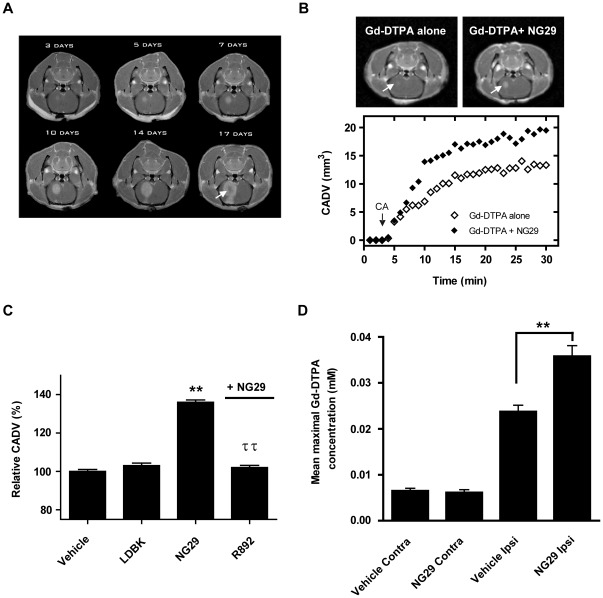
NG29 enhances transvascular delivery, distribution and accumulation of Magnevist within brain tumor tissues of F98-bearing rats.(A) MRI contrast-enhanced detection of glial brain tumors in rats at day 3, 5, 7, 10 14 and 17 post-inoculation. Note the rapidly growing tumor over a 2-week time and the appearance of a necrotic center on the 17 day-image (white arrow) outgrowing its blood supply. Assessment of BTB disruption by MRI monitoring was conducted on the same animal on day 10 post-inoculation, corresponding to mid stage development of the tumor. (B) Representative axial Magnevist-enhanced T
1-weighted MR images depicting the brain of an F98-implanted rat before and after NG29 treatment (10 nmol/kg/min for 5 min i.c.) (left panel). Note the increase in the signal intensity at the tumor (white arrows). Temporal CADV calculated from the corresponding sets of images (1 image/51 s for 50 min) (bottom panel). (C) Relative CADV in percent determined following the infusion of the vehicle (saline), LDBK, NG29 (10 nmol/kg/min for 5 min) or NG29 (10 nmol/kg/min, 5 min) + R892 (20 nmol/kg/min, 5 min). Each bar represents the mean ± S.E.M. for 4 to 6 animals. **p<0.01 compared to vehicle-treated animals; ††p<0.01 compared to NG29-treated animals. (D) Histographic representation of average maximal Gd-DTPA concentrations in the ipsilateral (tumor-implanted) and the contralateral hemispheres following saline vehicle or NG29 treatment (10 nmol/kg/min)). Note the superior levels of Gd-DTPA (reflecting greater basal permeability) in the ipsi- versus contralateral tissues of vehicle-treated animals (not illustrated, ***p<0.001). **p<0.01 compared to vehicle-treated ipsilateral groups. Value represents the mean ± S.E.M. obtained with 3 animals.